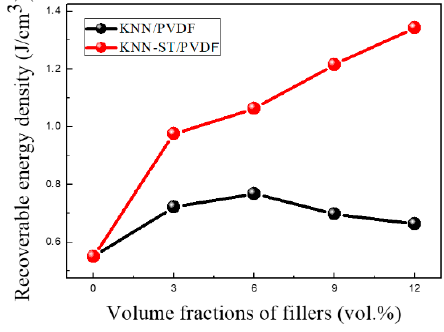
Figure 8. Recoverable energy density of KNN/PVDF and KNN-ST/PVDF composites films.